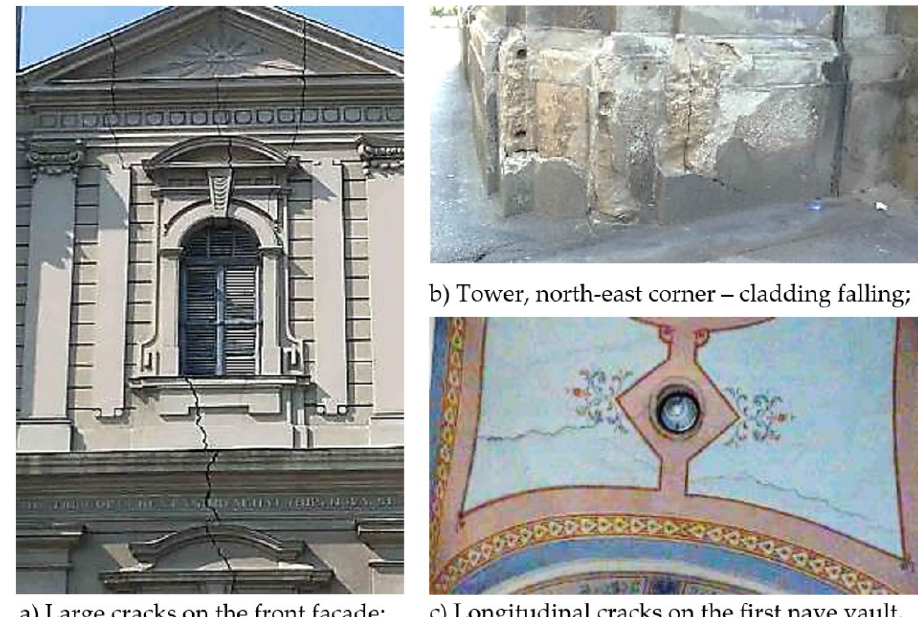
Figure 8. Characteristic damages: facade wall, tower wall cladding, cracks in the nave vaults.